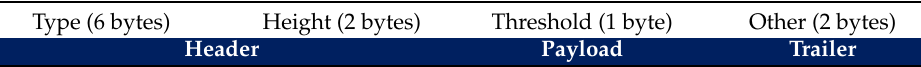
Table 1. UAV beacon message.